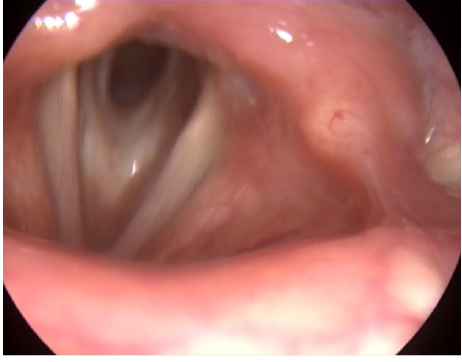
Figure 2. Subglottic stenosis. The audiogram showed mixed hearing loss after repeated otitis for which she had tympanotomy (Figure 3).